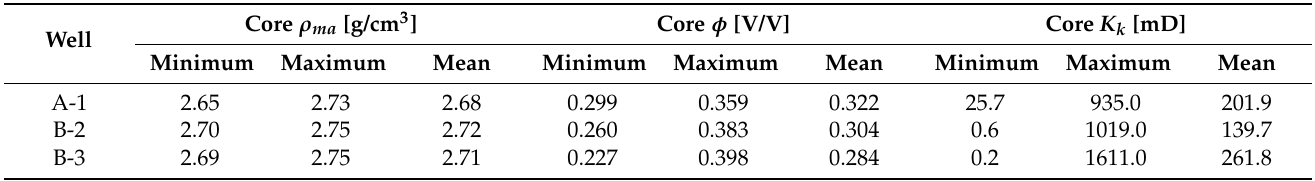
Table 2. Summary statistics of routine core measurements performed at quasi-reservoir confining pressure for A-1, B-2, and B-3 wells—“Sand” and “Silt” intervals.